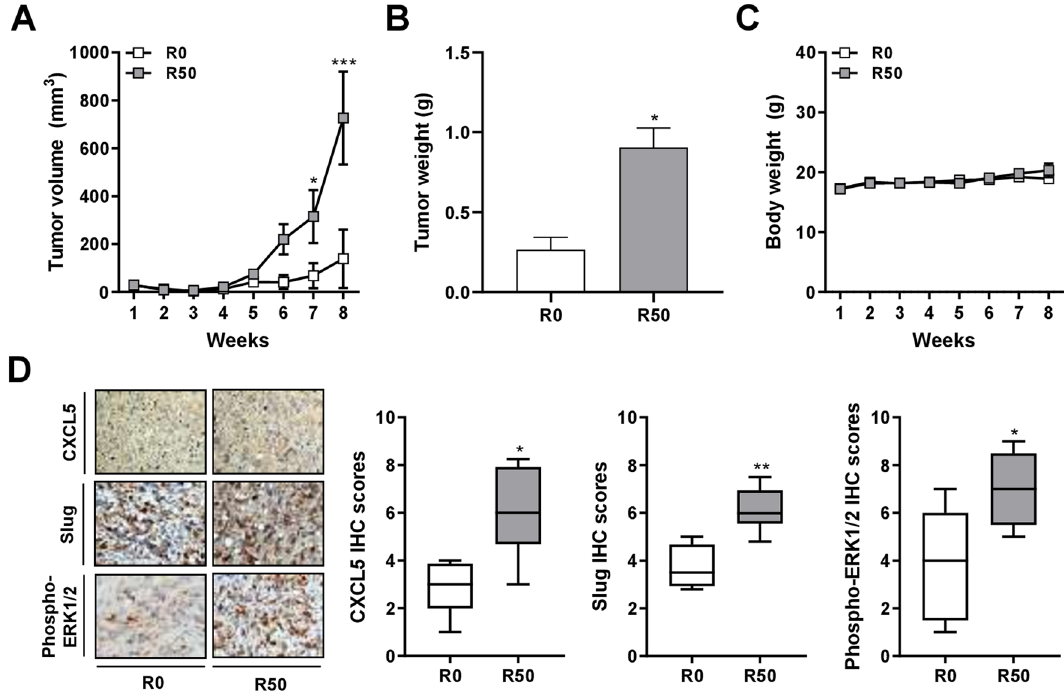
Figure 5. Enhanced breast tumor growth and protein expression of CXCL5, Slug, and ERK phosphorylation in mice via xenograft of breast cancer cells after co-culture with resistin-stimulated ADSCs. The isolated ADSCs were treated with resistin at 0 and 50 ng/ml (denoted as R0 and R50, respectively) for 48 h, followed by co-culture with MDA-MB-231 cells in the transwell model for another 72 h. After the co-culture, MDA-MB-231 cells were collected and injected into the fourth mammary fat pads of female NOD/SCID mice for the following analyses. ( A ) The tumor volume, calculated by (width 2 × length)/2, was measured weekly after palpable tumor mass was formed. ( B ) Upon sacrifice of the mice on week eight, the weight of individual tumor mass was measured. ( C ) The body weight of the mice was measured weekly. ( D ) The tumor mass was collected after sacrifice of the mice on week eight, and analyzed for CXCL5, Slug, and phospho-ERK1/2 protein expression by immunohistochemistry (IHC). The quantitative IHC scores were manually evaluated and calculated by multiplying the categorized percentage of stained cells (0, 0–24%; 1, 25-49%; 2, 50-74%; 3, 75-100%) by the categorized intensity of staining (0, negative; 1, weak; 2, moderate; 3, strong). Data were obtained from three to six mice in each group and presented as mean ± SEM or box plots. Statistical difference was determined by t-test comparing R50 group versus R0 group as control. * p < 0.05; ** p < 0.01; *** p <